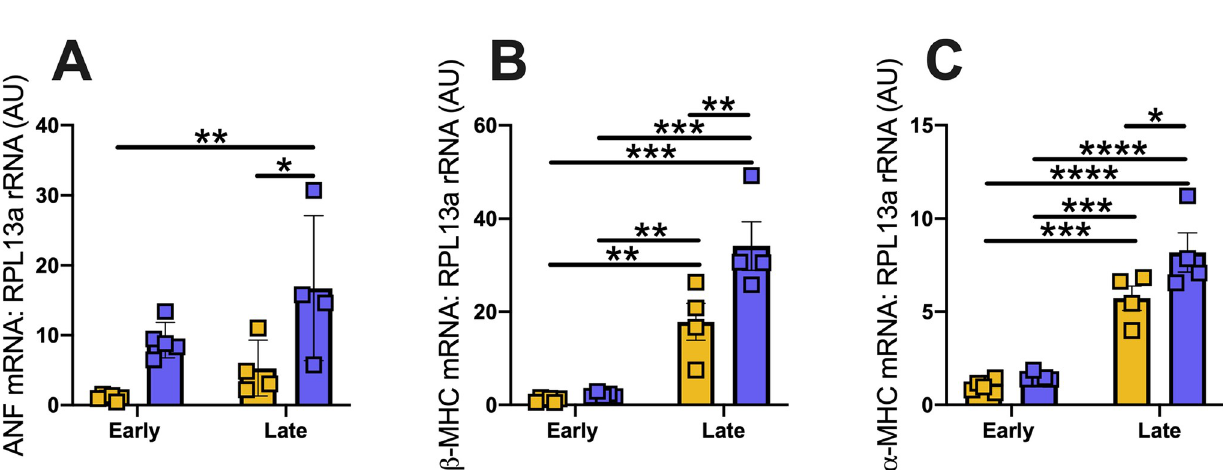
Fig 3. RT-qPCR analysis of cardiac genes in heart tissue from GK and Wistar rats over time. (A) Atrial natriuretic Factor, (B) beta-Myosin Heavy Chain ( β MHC), (C) alpha-myosin heavy chain ( ⍺ MHC). Where Early = 28 weeks and Late = 48 weeks. � = p < 0.05, �� = p < 0.01, ��� = p < 0.001 and ���� = p < 0.0001. A Two-Way ANOVA with multiple comparisons Holm-Sidak test was used to compare groups across different time points. Yellow = Wistar and Blue = GK. Data is expressed as mean ± SEM N = 4–8 per group.